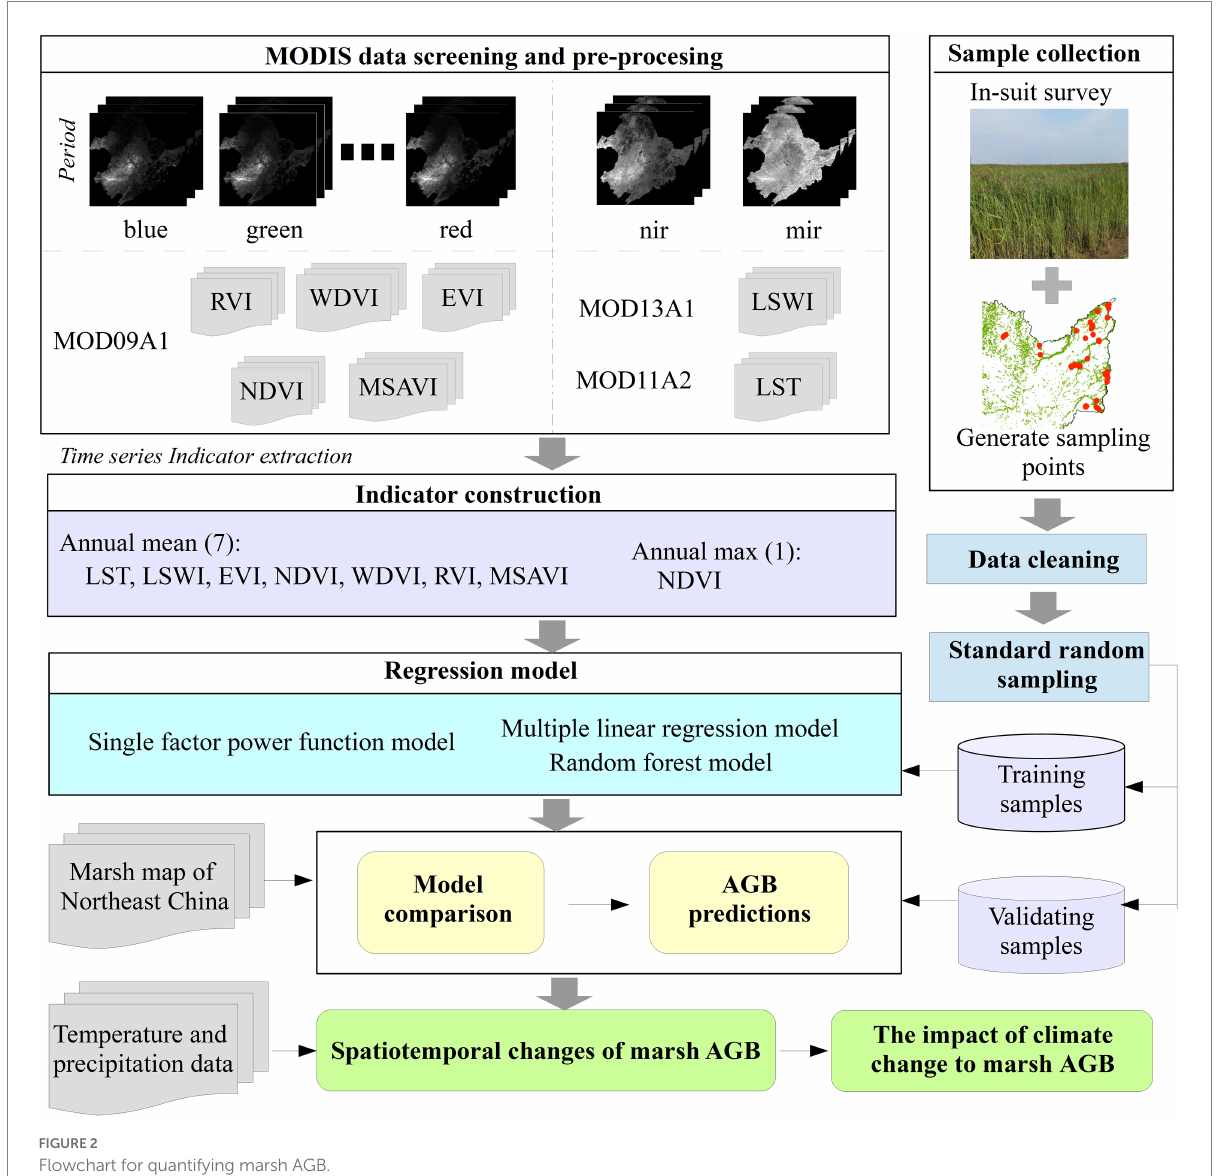
FIGURE 2 Flowchart for quantifying marsh